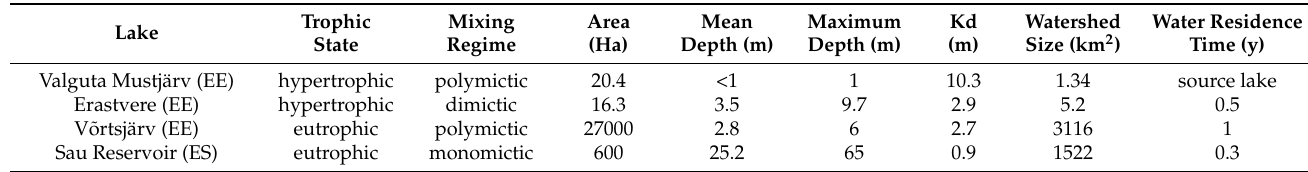
Table 1. Characteristics of the studied lakes. Values represent long-term averages. Trophic Mixing Lake State